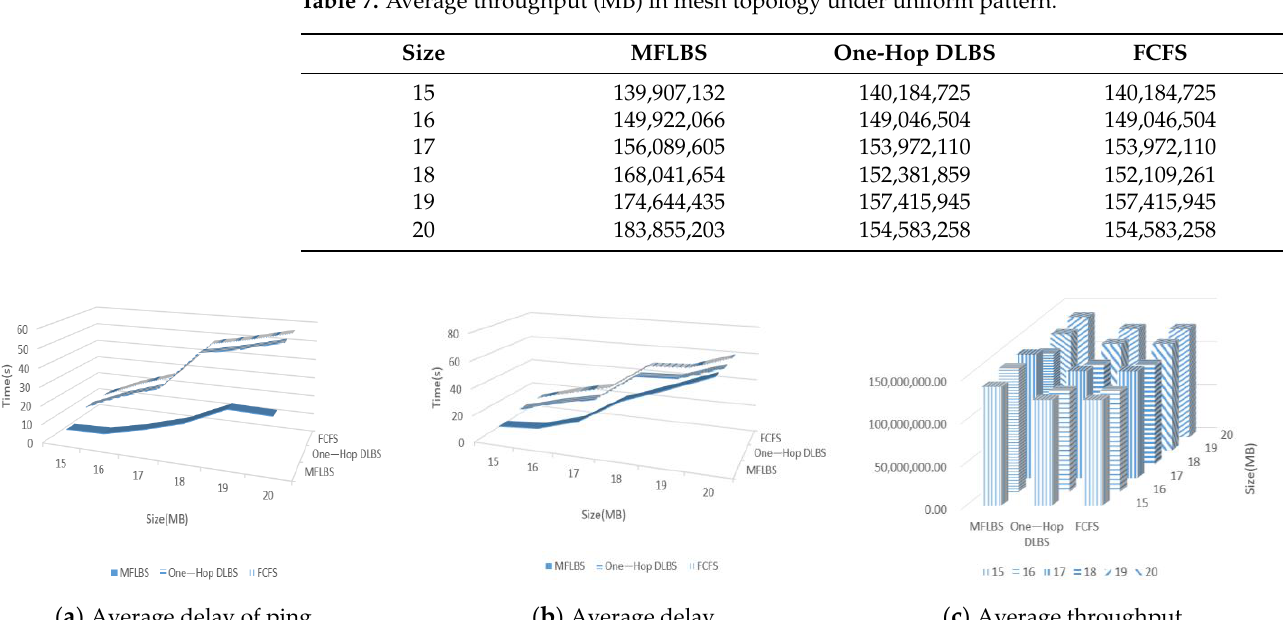
Figure 8. Three algorithms in mesh topology under semi-central pattern.